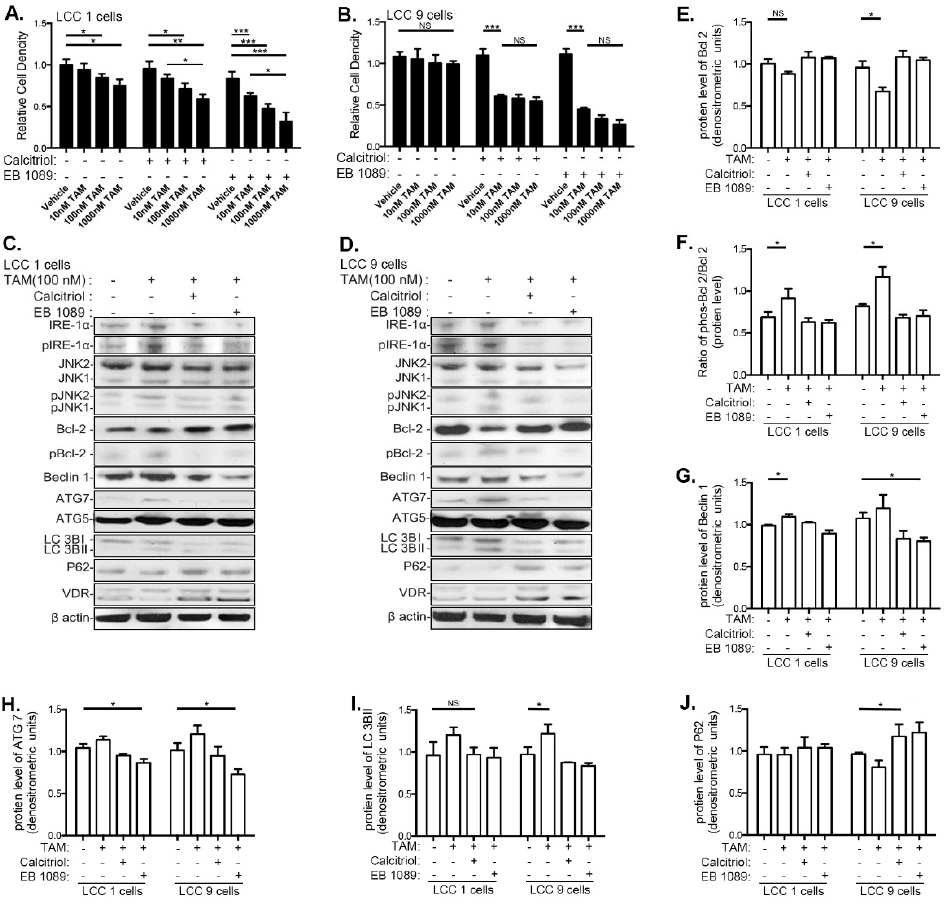
Figure 4. Calcitriol and EB1089 restore responsiveness of breast cancer cells to TAM treatment. Cells were treated with increasing doses of TAM (0–1000 nM), combined with vehicle (ethanol), calcitriol (100 nM) or EB1089 (100 nM) for 3 days, respectively. Relative cell density was determined by crystal violet assay. ( A ) LCC1 cells, ( B ) LCC9 cells. Representative blot from Western blot analyses of UPR and autophagy genes in ( C ) LCC1 cells, ( D ) LCC9 cells. Quantification of protein expression of ( E ) total Bcl-2, ( F ) the ratio of pBcl-2 over total Bcl-2, ( G ) Beclin 1, ( H ) Atg7, ( I ) LC3BII, and ( J ) p62. Quantification based upon three independent biologic replicates. β -actin was used a loading control. * p < 0.05; ** p < 0.01; *** p < 0.001; NS: not significant. Means ± standard error of means are shown.